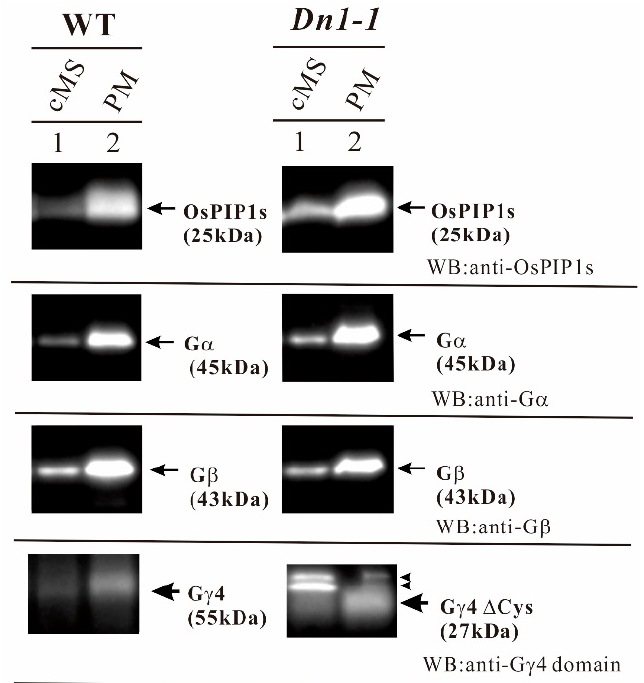
Figure 5. G γ 4 and G γ 4 ∆ Cys in leaf sheath of wild type (WT) and Dn1-1 were enriched in the plasma membrane fraction (PM). Ten micrograms of each crude microsome fraction (cMS) and plasma membrane (PM) proteins from wild type (WT) and Dn1-1 were analyzed by western blot using anti-OsPIP1s, anti-G α , anti-G β , and anti-G γ 4 domain antibodies. OsPIP1s is an aquaporin and a plasma membrane marker. OsPIP1s (25kDa), G α (45kDa), G β (43kDa), G γ 4 (55kDa), and G γ 4 ∆ Cys (27kDa) are indicated by arrows. Non-specific bands are indicated by arrowheads.